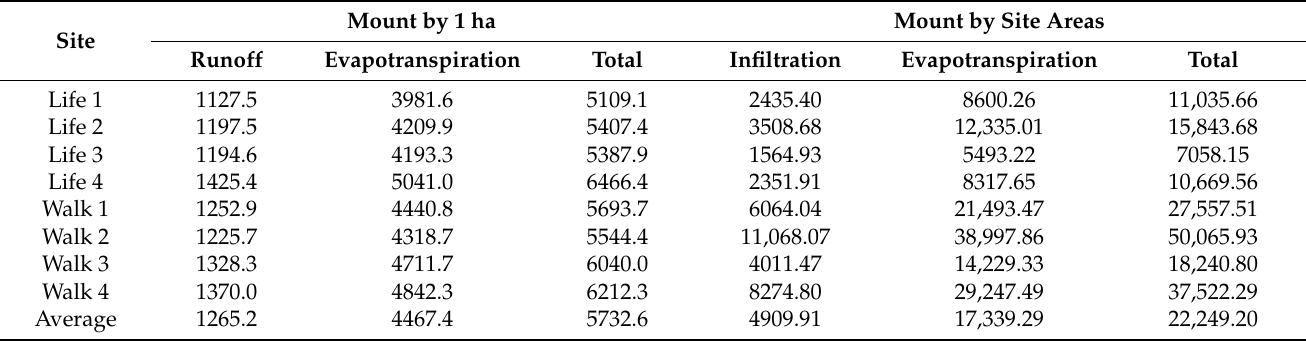
Table 7. Results of evaluating the water resource recharge amount of the study